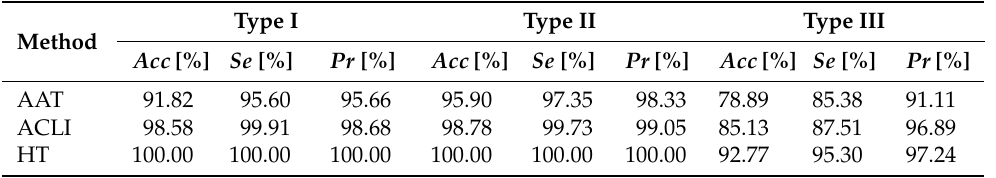
Table 1. Electrogram detection performance results for all AF types of the three LAW detectors compared in this study in terms of Accuracy ( Acc ), Sensitivity ( Se ) and Precision ( Pr